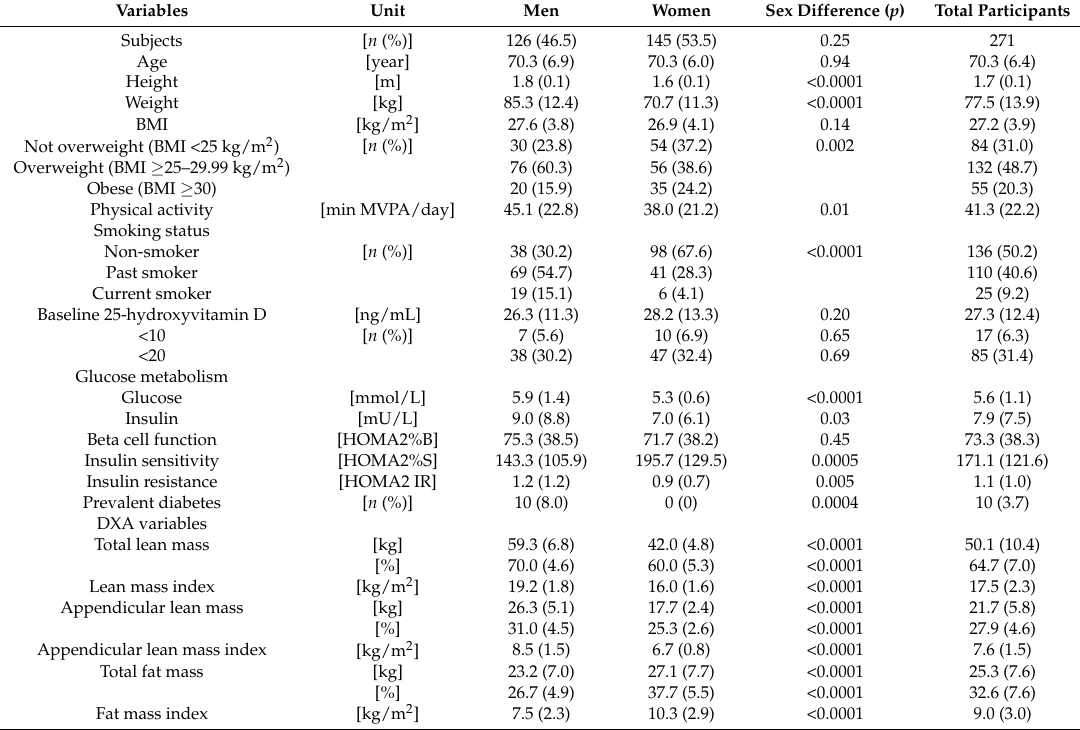
Table 1. Characteristics of participants of the Zurich Knee Osteoarthritis trial by sex.